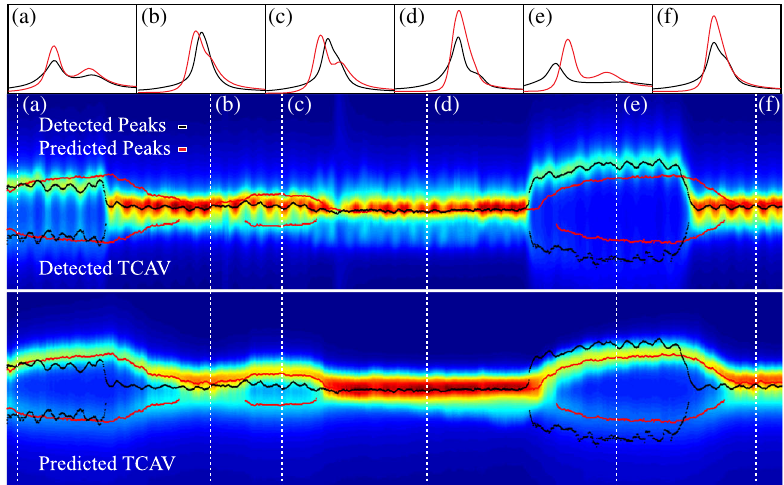
FIG. 7. A top-down view of the actual and predicted bunch profile measurements shows that L i T rack ES was able to track changes in the bunch profile, including a successful prediction of when there was a single bunch and when it was split in two as is done in driver- witness plasma wakefield acceleration experiments. Color, from blue to red, indicates increasing detected intensity. The red and black lines placed on top of the detector intensities show the predicted and measured peaks, respectively. Plots (a) – (f) show actual and predicted longitudinal beam profiles as measured and predicted along the white dashed lines (a) – (f).